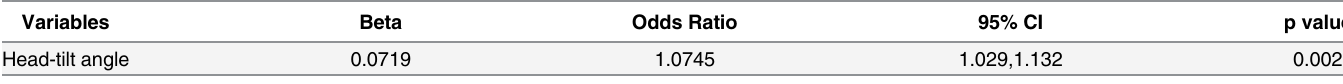
Table 2. Logistic Regression Model of Patent Airway vs Head-tilt Angle.